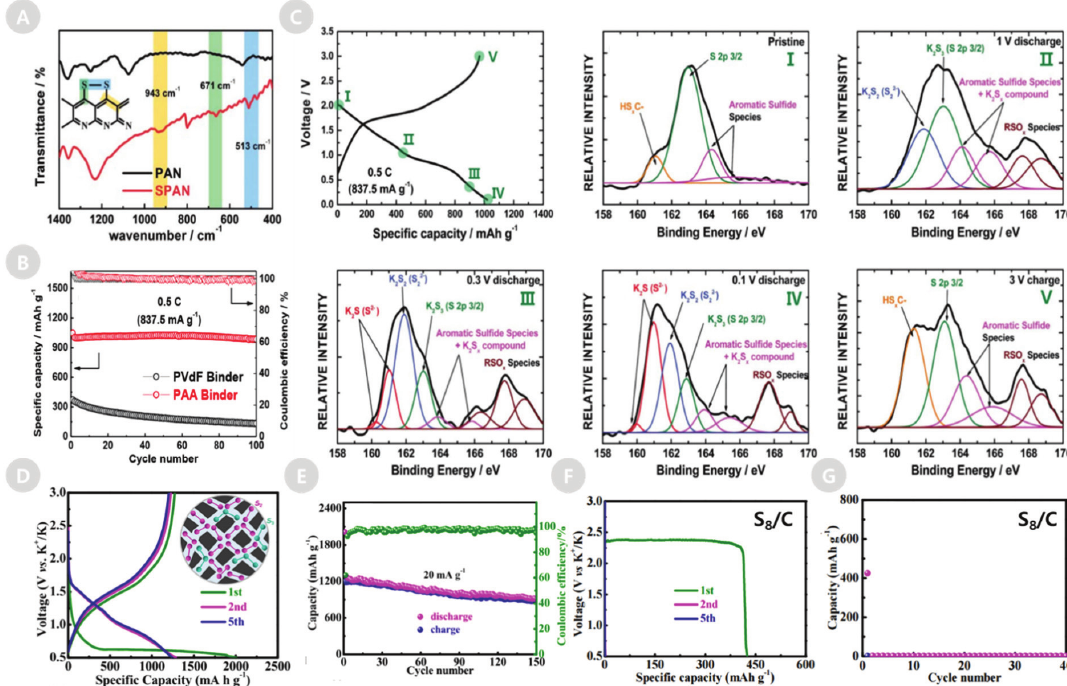
Figure 4. ( A ) Results of FT-IR analysis of polyacrylonitrile (PAN) and a sulfurized polyacrylonitrile nanocomposite (SPAN) structure. Figure adapted from Reference [18]. ( B ) Comparison of cycle life of SPAN electrode depending on binder. Figure adapted from Reference [18]. ( C ) Charge–discharge voltage profiles and XPS analysis of SPAN electrode with polyacrylic acid (PAA) binder at different states of charge: pristine, discharged at 1 V, discharged at 0.3 V, discharged at 0.1 V, and charged at 3 V. Figure adapted from Reference [18]. Comparison of ( D and F ) charge–discharge profiles and ( E and G ) cycling stabilities of the micro porous structured C/S composite and conventional S/C composite electrodes. Figure adapted from Reference [16].